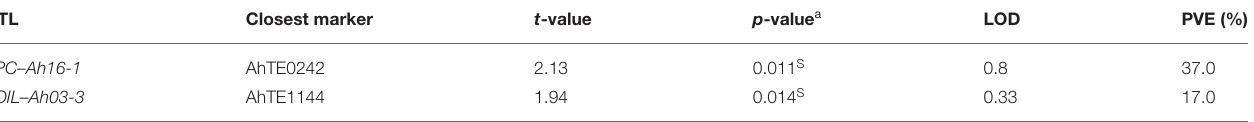
TABLE 5 | Validation of QTL and markers linked to oil and protein content in